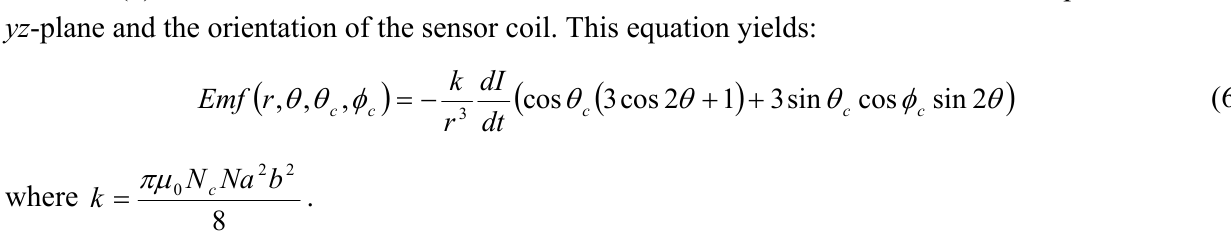
Sensor coil 1 Sensor coil